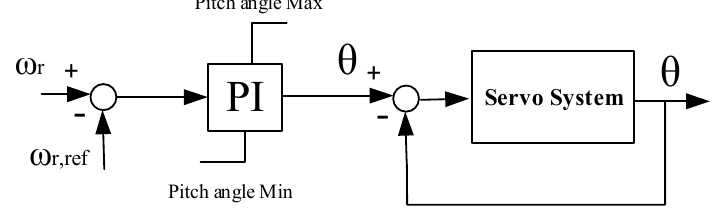
Figure 4. Pitch angle controller for variable speed wind turbine.